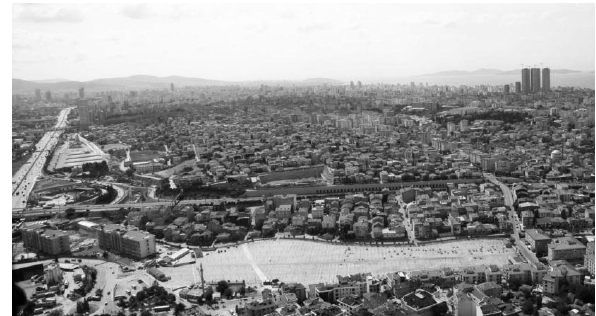
Figure 2: Current Structure in Fikirtepe